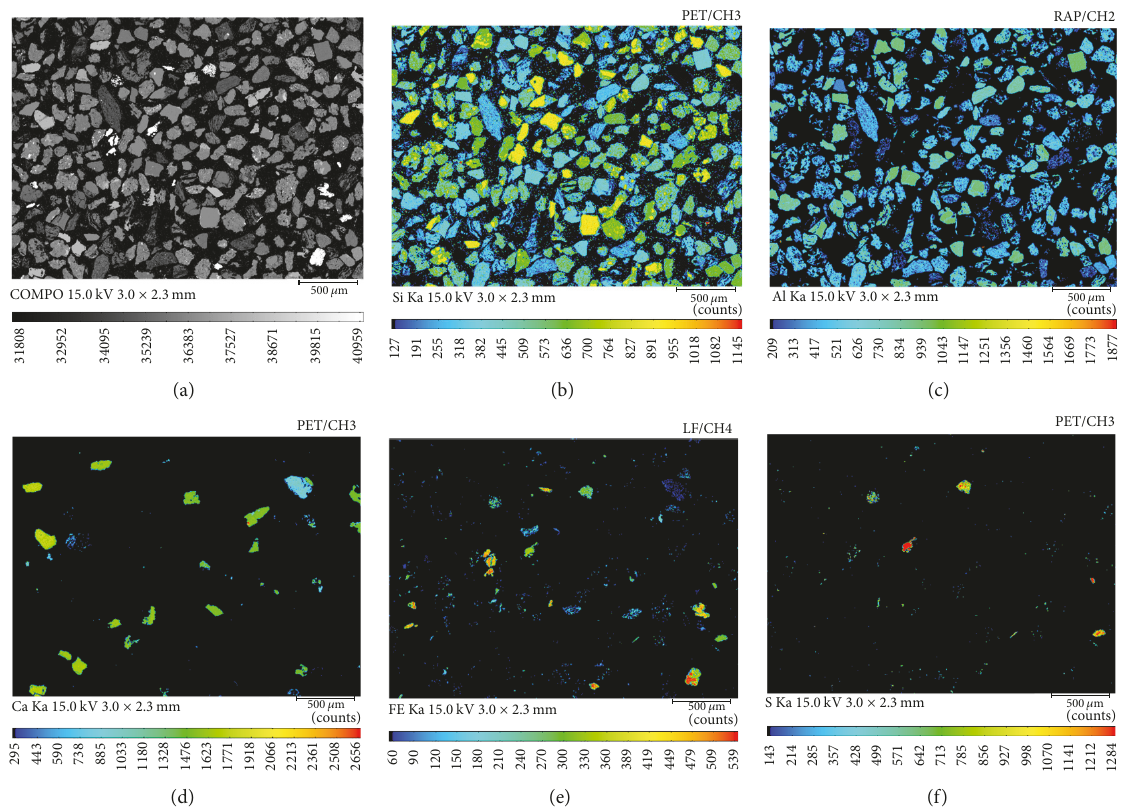
Figure 6: Surface distribution of elements in heavy product: (a) backscatter imagery of heavy product; (b) Si; (c) Al; (d) Ca; (e) Fe; (f) S.